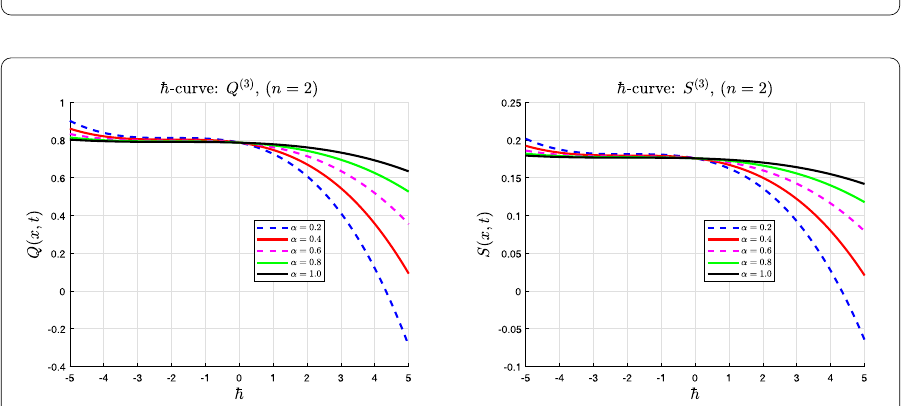
Figure 23 (cid:2) -curves plot with different α when r = 0.1, B = 3, x = 1, and t = 0.1 for Example 4.3